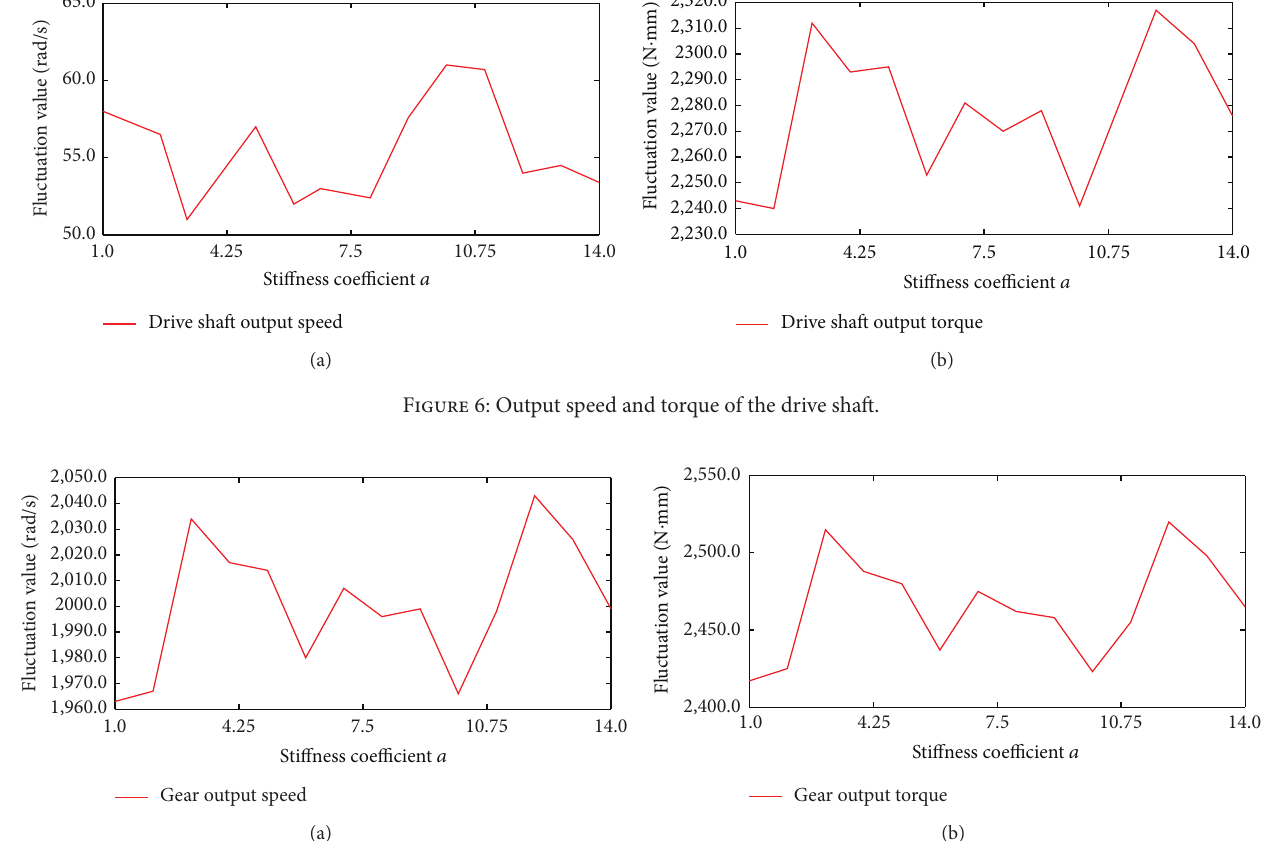
Figure 7: Output speed and torque fluctuations of the driven gear.